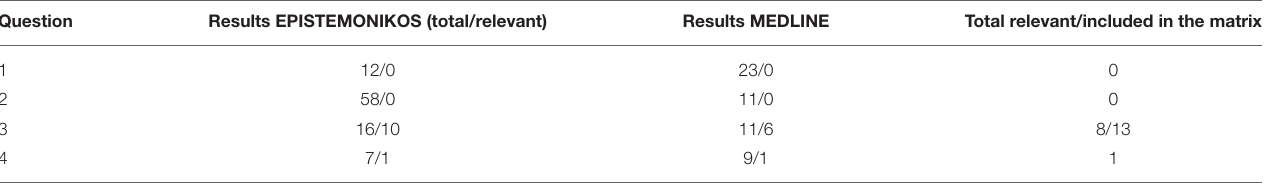
TABLE 2 | Results of the search